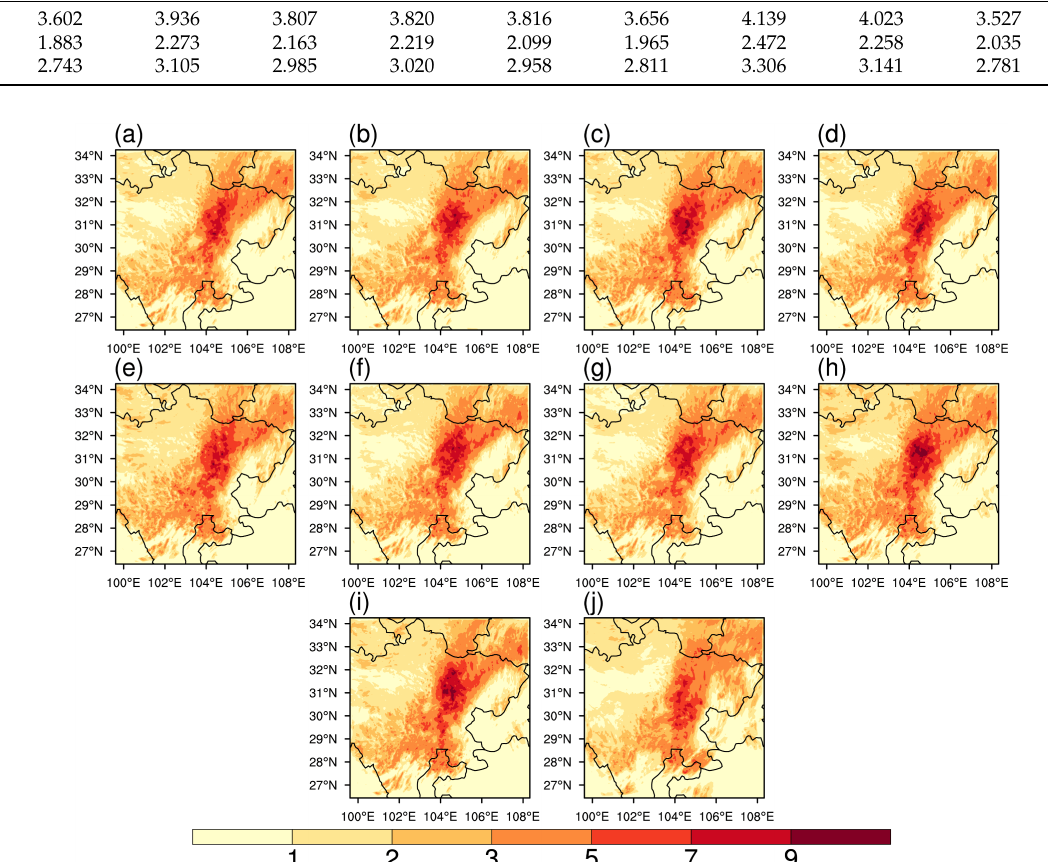
Figure 14. Spatial distribution of STD values for 24-h cumulative precipitation (mm) of Case1. Panels from ( a – j ) stand for P1 to P10,